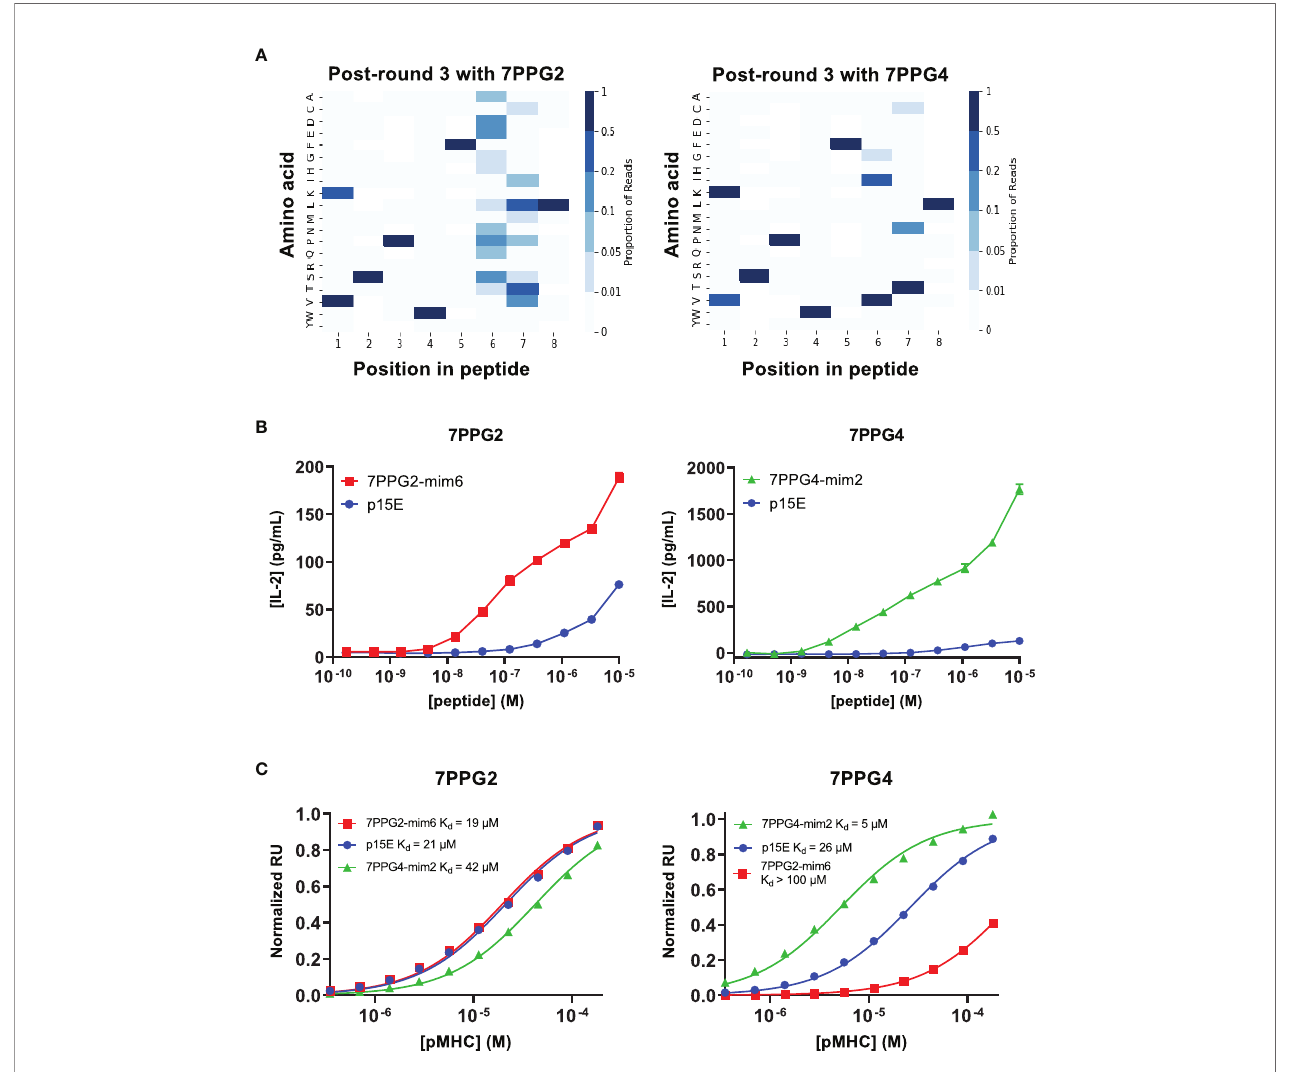
FIGURE 5 | Screening of a yeast displayed peptide-MHC library allowed the identi fi cation of mimotopes that more potently activate T cells of interest. (A) Deep sequencing was performed on yeast following each round of selection to reveal amino acid preferences for binding to 7PPG2 and 7PPG4 TCRs. Heat maps show preference for each peptide position, weighted by read count, following 3 rounds of selection with the indicated TCR. (B) TCR-transduced T cells were cocultured with DC2.4 cells loaded with mimotope or p15E peptides. T cell activation was assessed by IL-2 ELISA. Data shown are mean+s.e.m. for triplicate samples and are representative of 3 independent experiments. (C) Surface plasmon resonance was used to quantify af fi nities between TCRs and mimotope or p15E peptides displayed by H-2K b